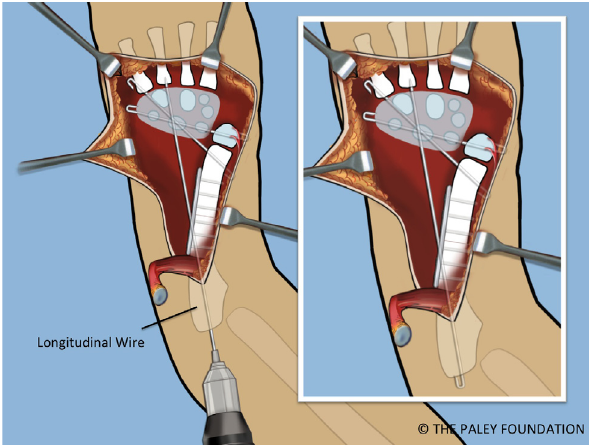
Figure 22. A third temporary wrist arthrodesis wire is inserted from the olecranon in a longitudinal antegrade fashion to exit the ulna and transfix the carpus. This wire is also cut and curled proximally.